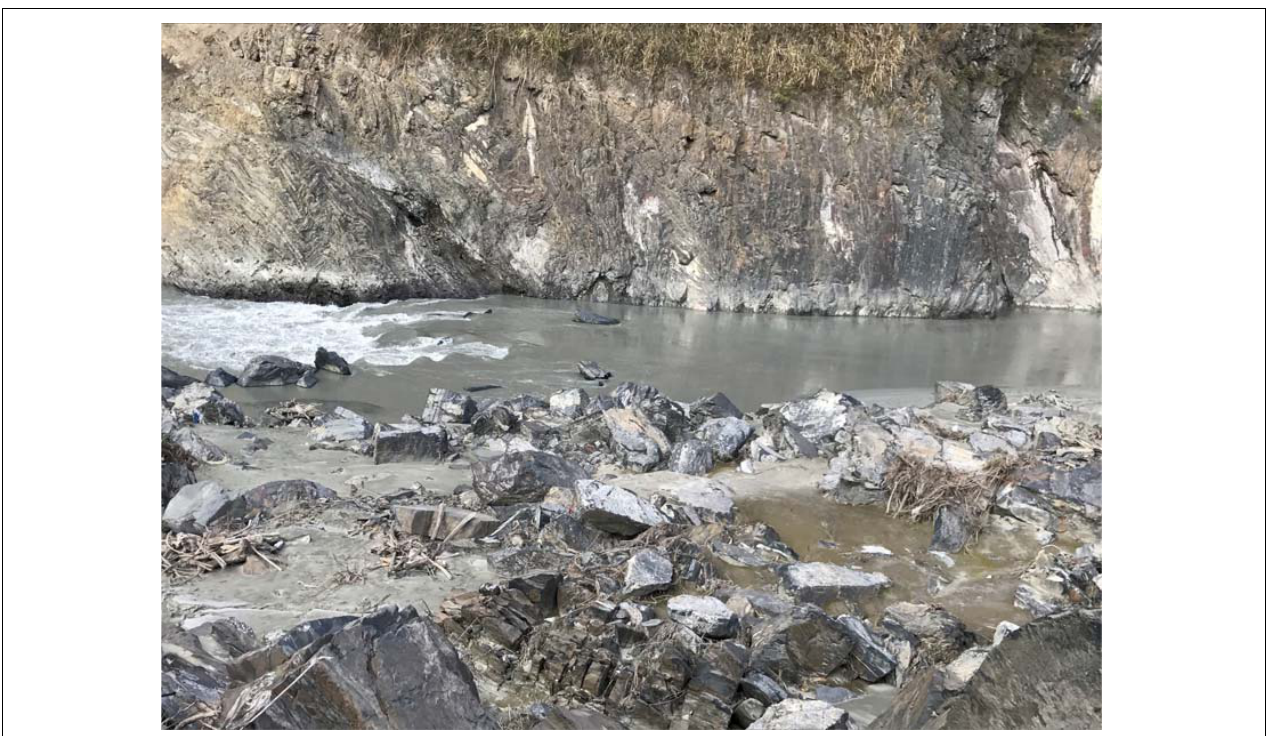
FIGURE 1 | Photograph of Tangjiashan landslide dam at the breach site more than 12 years after the outburst flood (imaged on December 21, 2020).